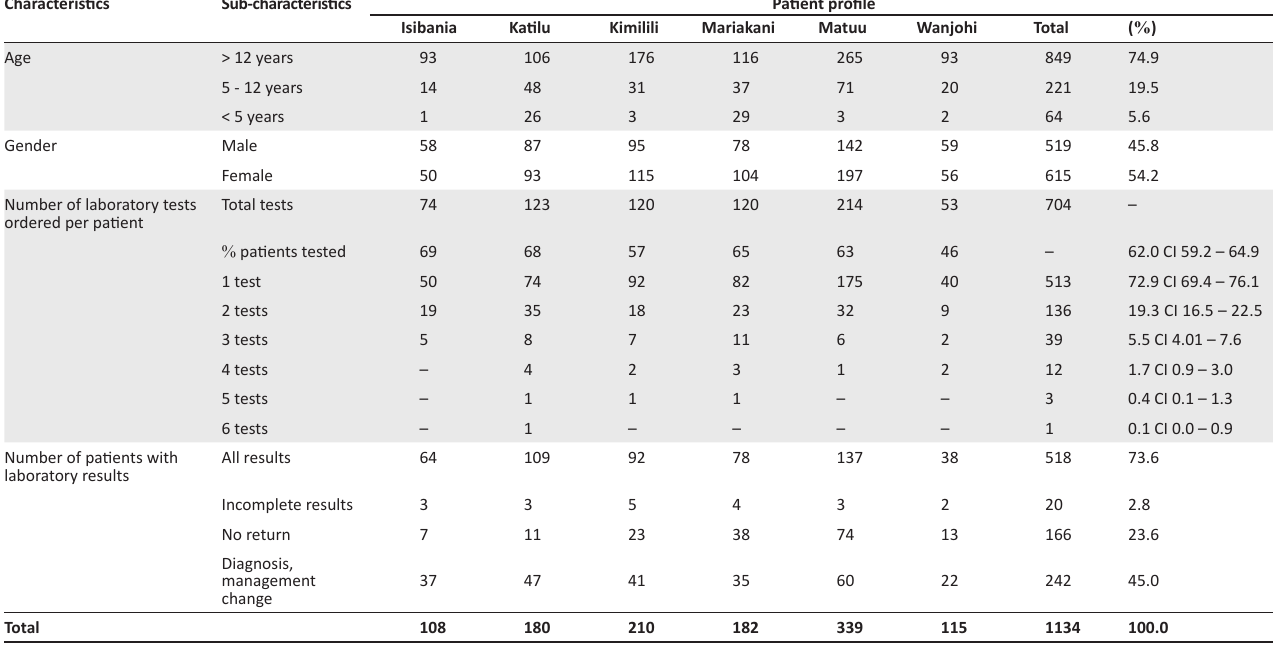
TABLE 1: Patient characteristics, profile of laboratory testing and change in patient management. Characteristics